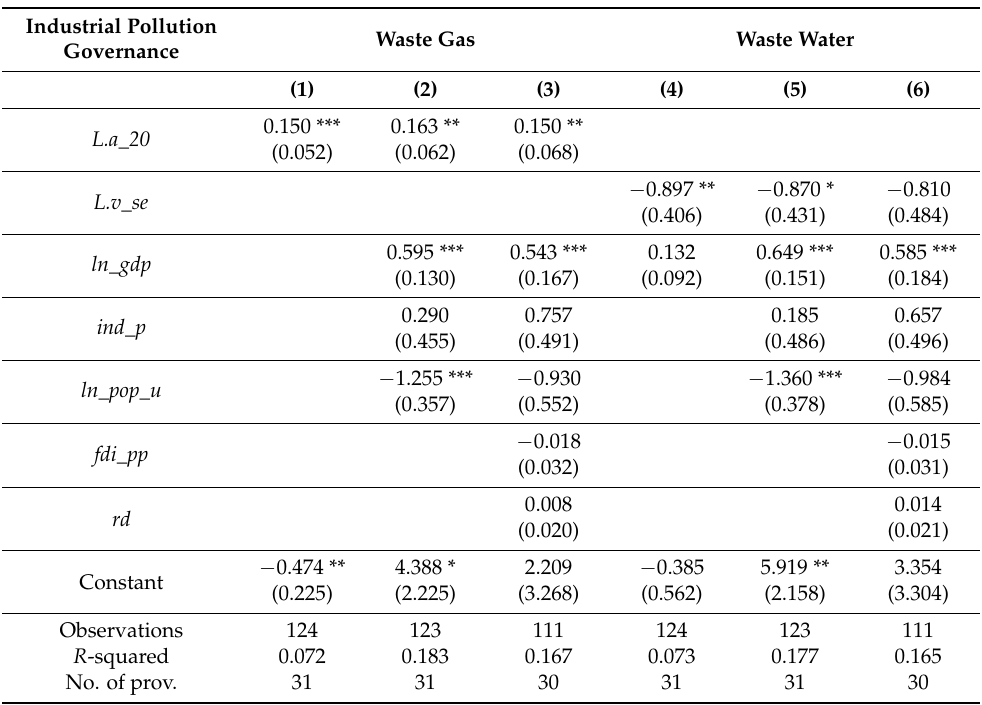
Table 5. Robustness test on the industrial pollution governance investment response vis- à -vis public environment dissatisfaction.